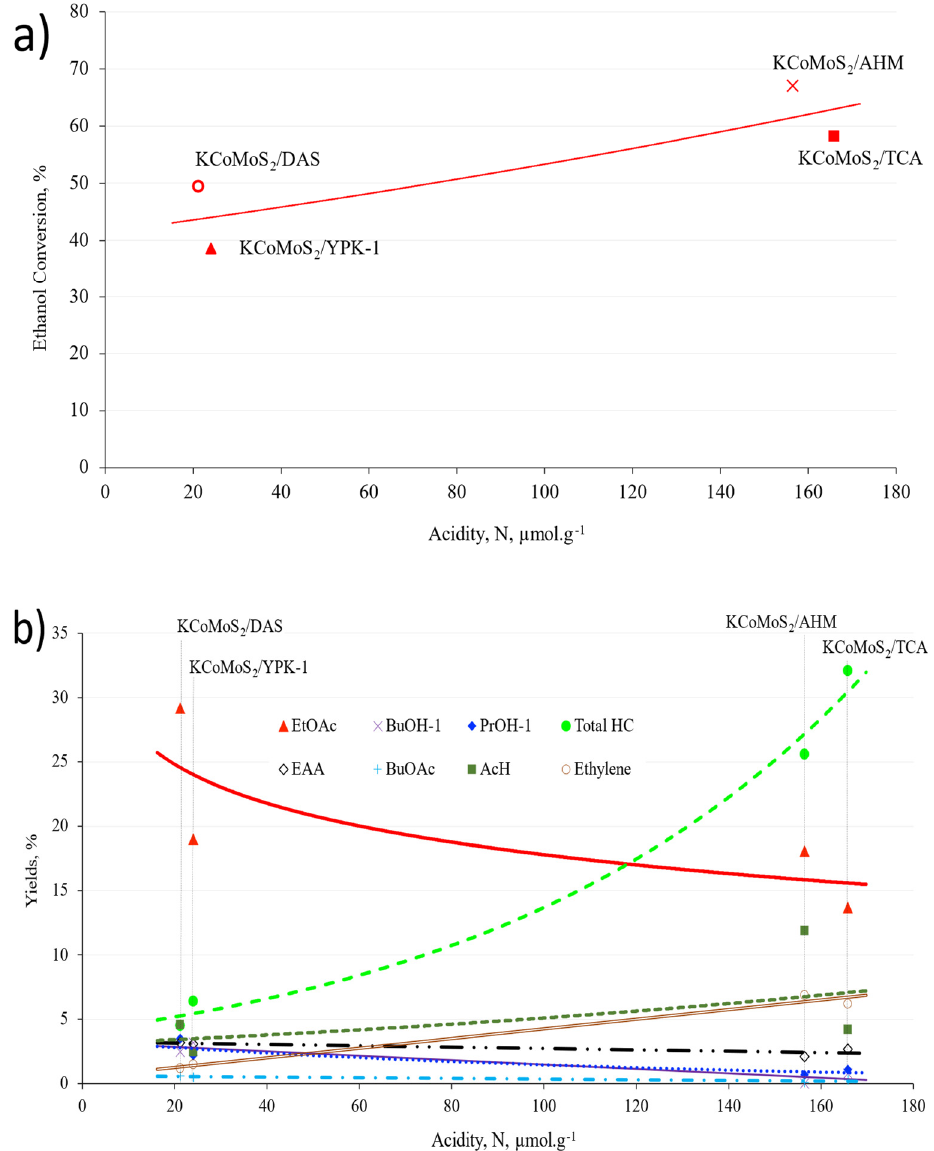
Figure 7. Total acidity as a function of ( a ) ethanol conversion and ( b ) product yields at 320 °C for all K-promoted trimetallic CoMo-supported catalysts (Reaction conditions: T = 320 °C, m cat = 3 g, P = 2.5 MPa, GHSV = 760 L h − 1 kg cat − 1 , and feed flow rate = 0.3 mL/min under